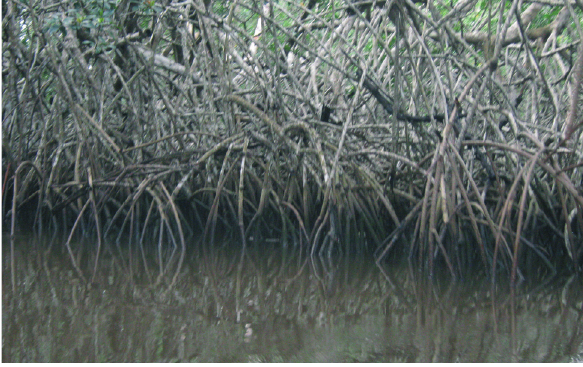
Fig. 3. – La mangrove dans le foyer de Bendjé, à marée